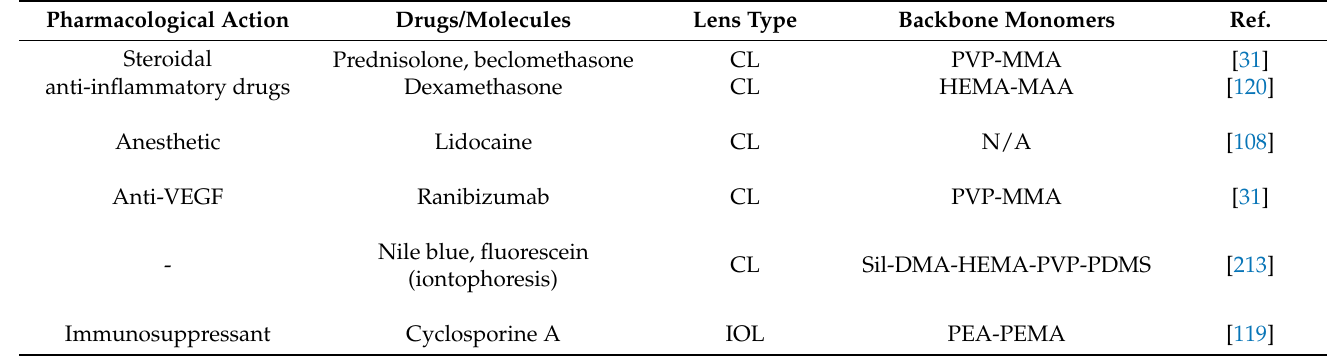
Table 4. Therapeutic ophthalmic lenses developed between 2010 and 2020 potentially suitable for the treatment of the back of the